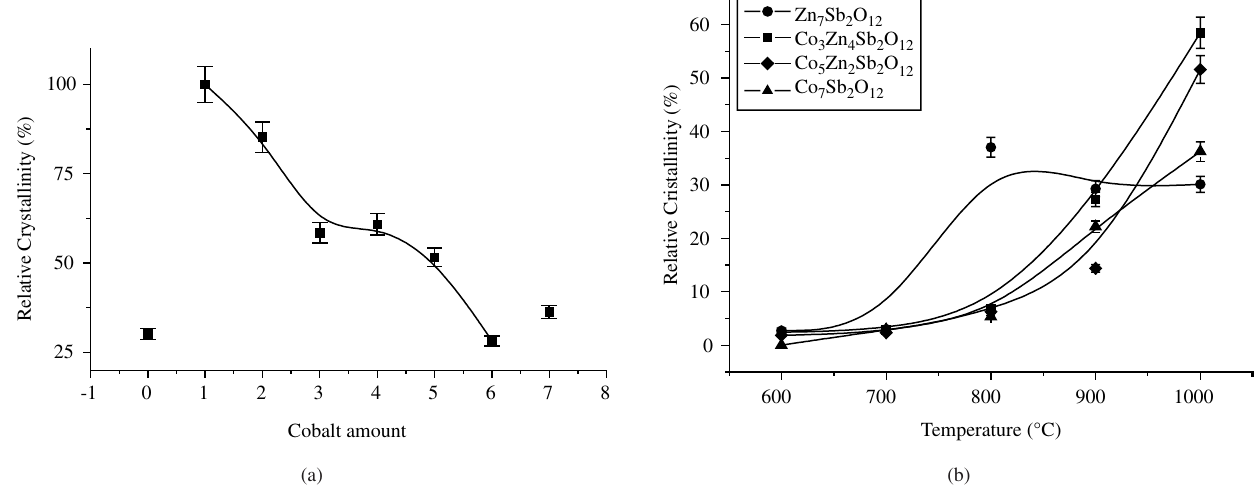
Figure 7. Relative crystallinity: a) Variation as a function of cobalt amount, after calcination at 1000° C; b) Variation as a function of